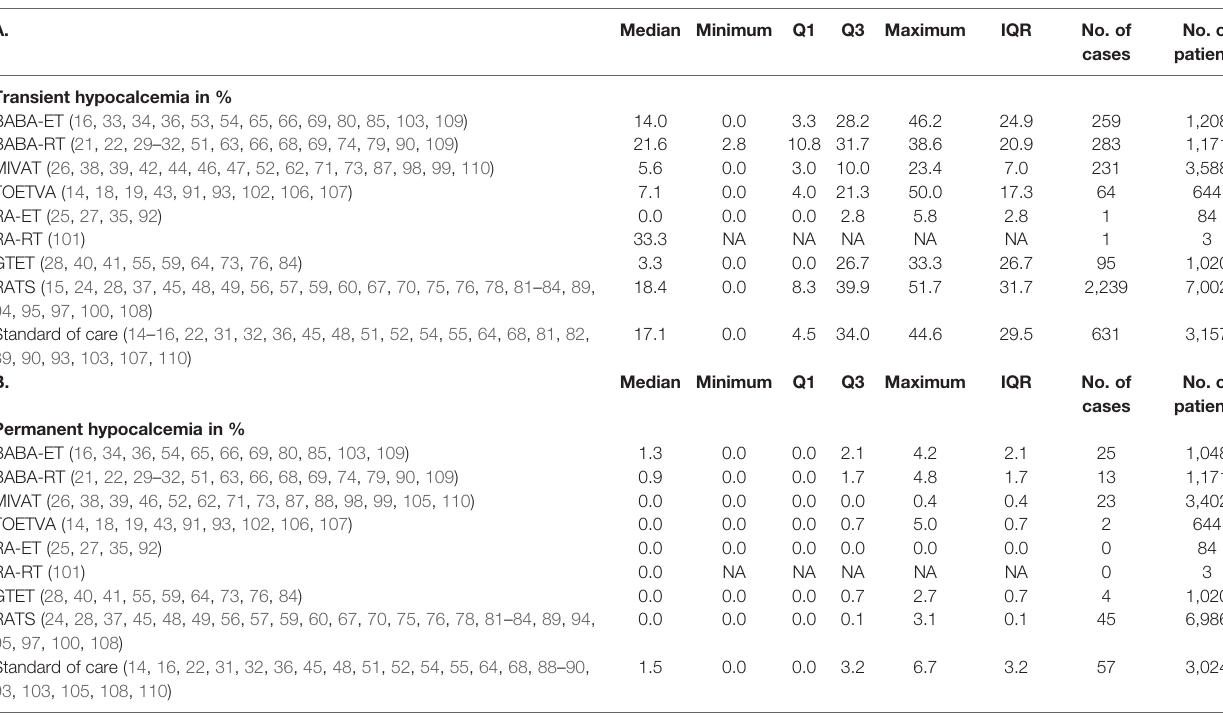
TABLE 3 | Incidence of